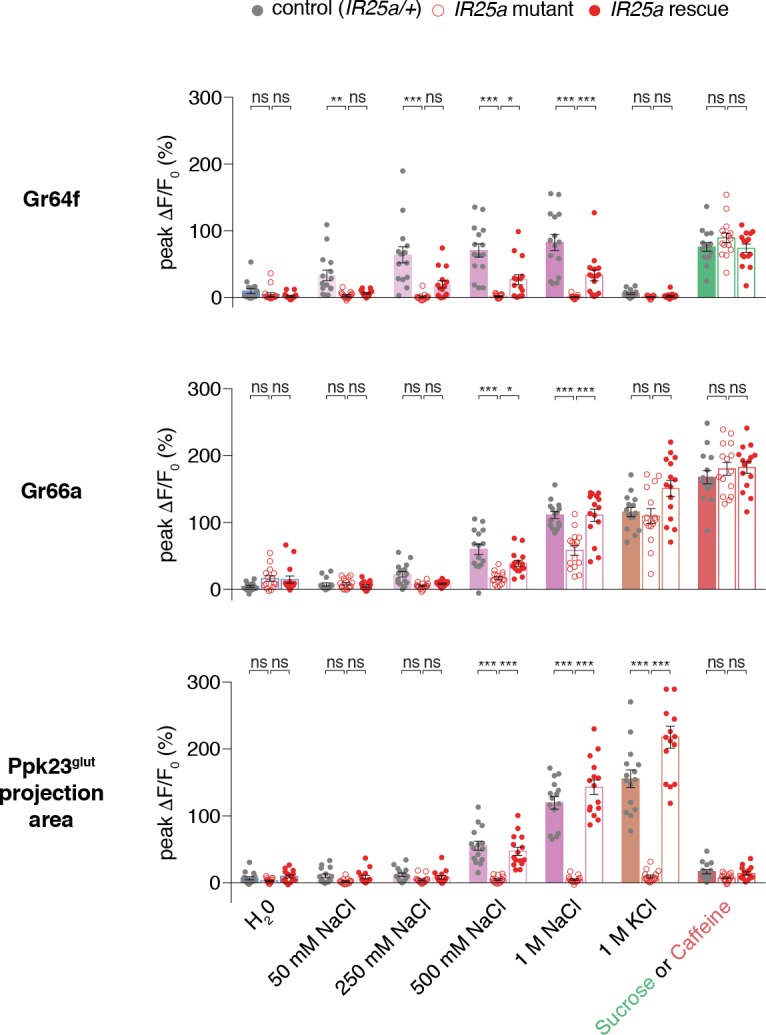
A subset of GRN salt responses requires IR25a.Peak values of GCaMP6f fluorescence changes for each GRN type in heterozygous controls (filled grey circles), IR25a mutants (open red circles), and rescues (filled red circles), following stimulation with the indicated tastants. Bars represent mean ±SEM, n = 15. Asterisks indicate significant difference between control and mutant or mutant and rescue responses for each stimulus by two-way ANOVA with Bonferroni post hoc test, *p<0.05, **p<0.01, ***p<0.001.